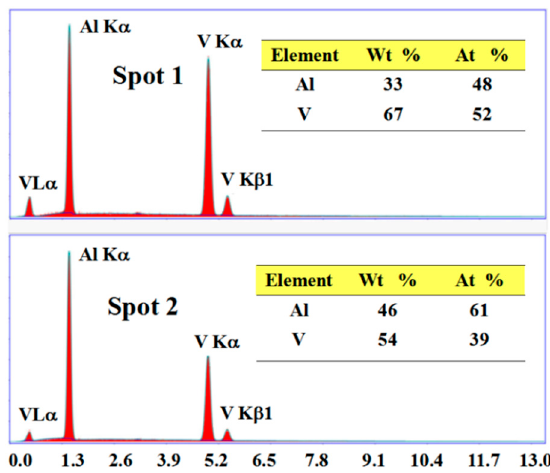
Figure 10. Energy dispersive spectrometer (EDS) analysis of the elements distribution in different